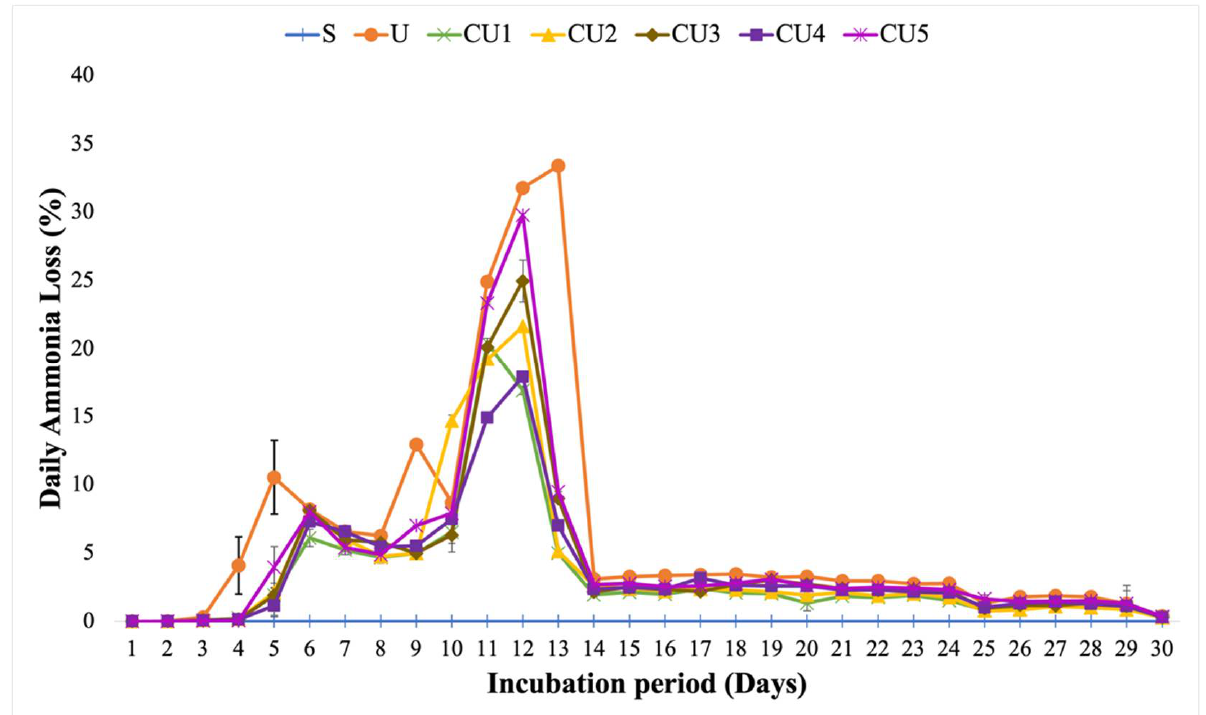
Figure 7. Ammonia volatilization over thirty days of incubation under waterlogged condition. Note: the error bars show the standard errors on the replicates in the mean of each treatment. Total NH 3 loss was higher in soil with uncoated urea compared with all RSS-coated urea except for urea coated with RSS at the 6% concentration (Figure 8). Urea coated with RSS in CU1 (2%), CU2 (3%), CU3 (4%), and CU4 (5%) significantly reduced NH 3 loss compared with uncoated urea (U) (Figure